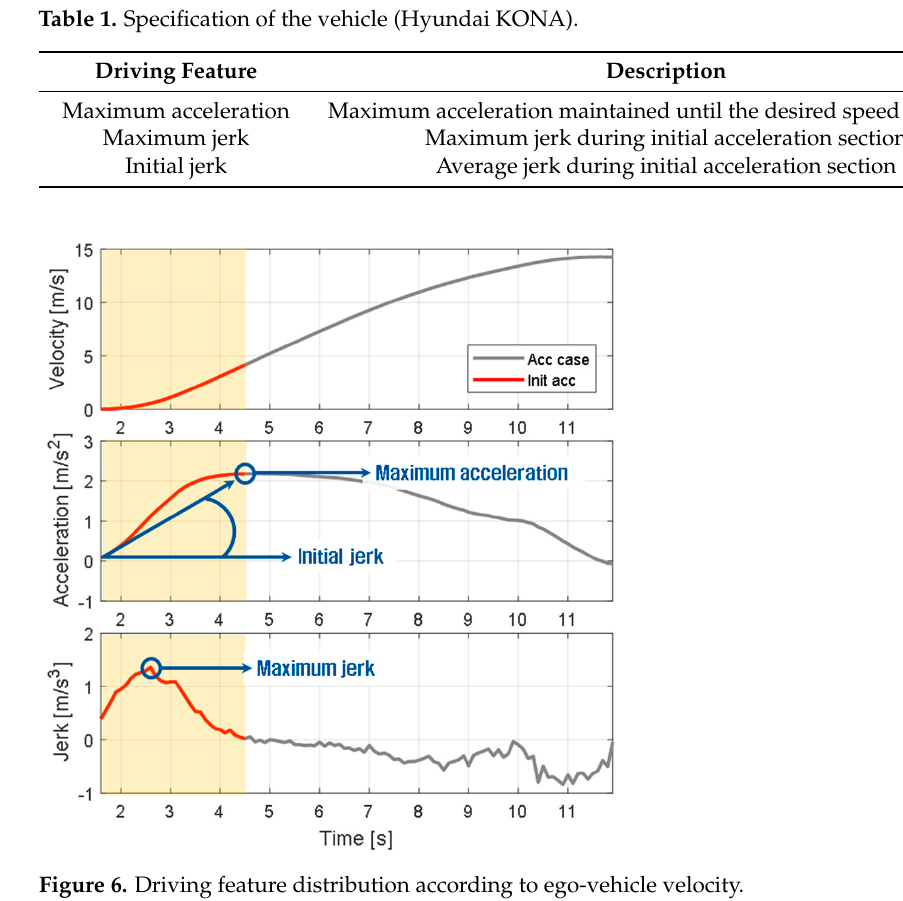
Figure 6. Driving feature distribution according to ego-vehicle velocity. Table 1. Specification of the vehicle (Hyundai KONA).